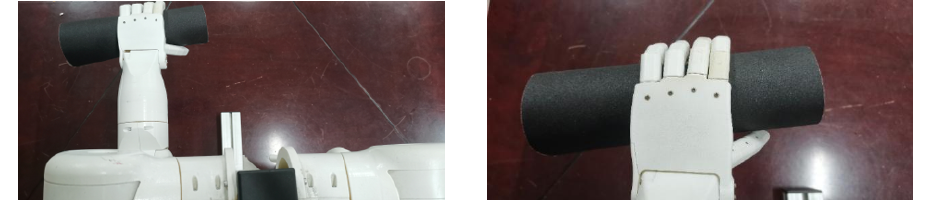
Figure 27. Robot finger grasping diagram.